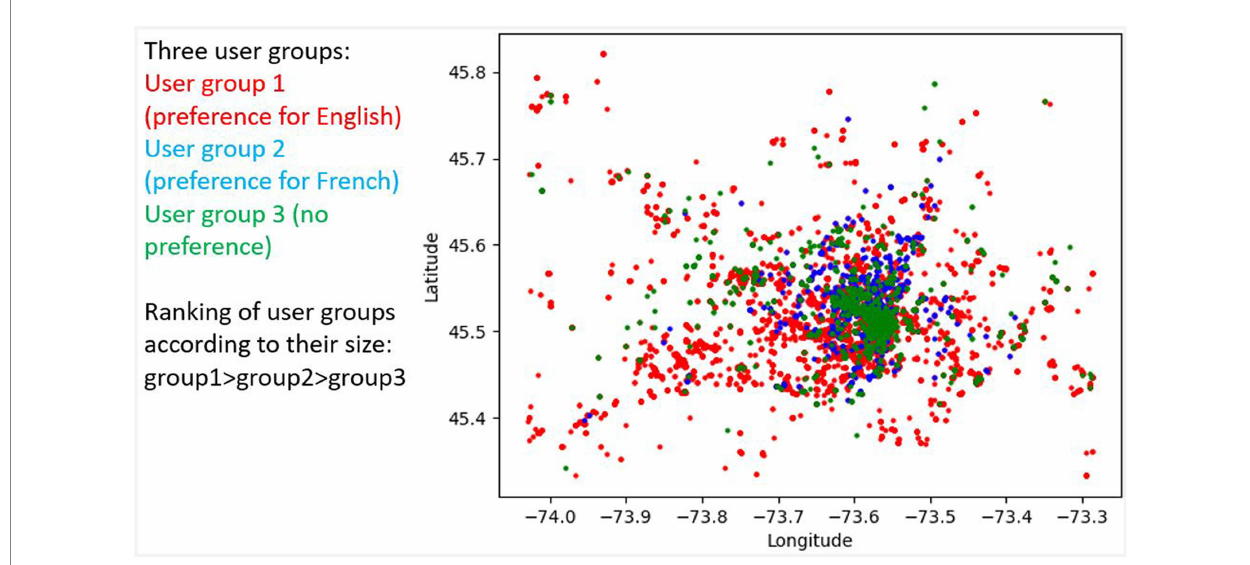
FIGURE 14 Distribution of English and French tweets per bilingual user group in GM. Tweets of bilingual users with preference for English (>90% tweets in English) in red, with preference for French in blue and with no preference in